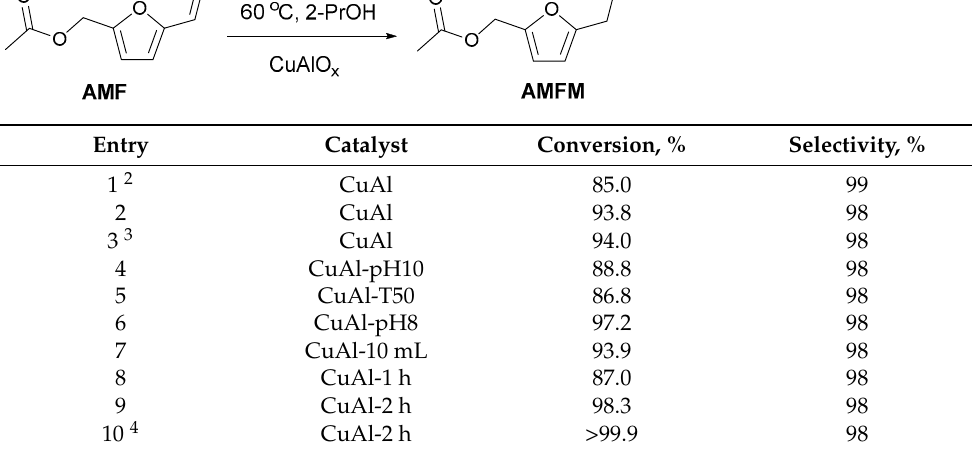
Figure 6. XRD measurements of the CuAl-pH8 and CuAl-10mL samples reduced at 120 °C.